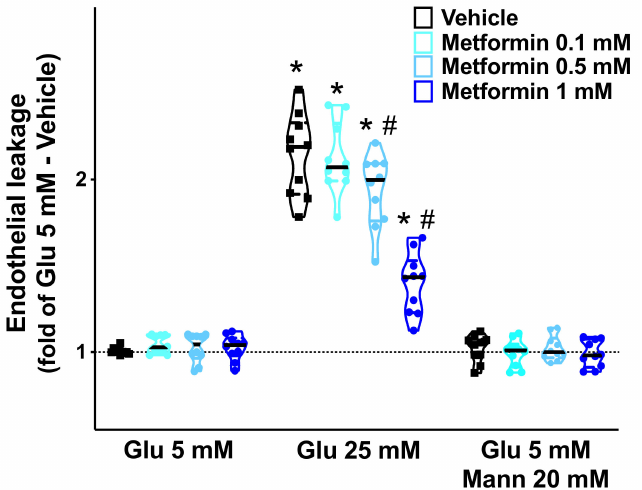
Figure 4. Effects of metformin on endothelial permeability. We assessed the dose-response rela- tionship of metformin on the leakage of human brain microvascular endothelial cells, cultured at the indicated conditions (Glu: glucose; Mann: mannitol); *: p < 0.05 vs. Glu 5 mM; #: p < 0.05 vs.